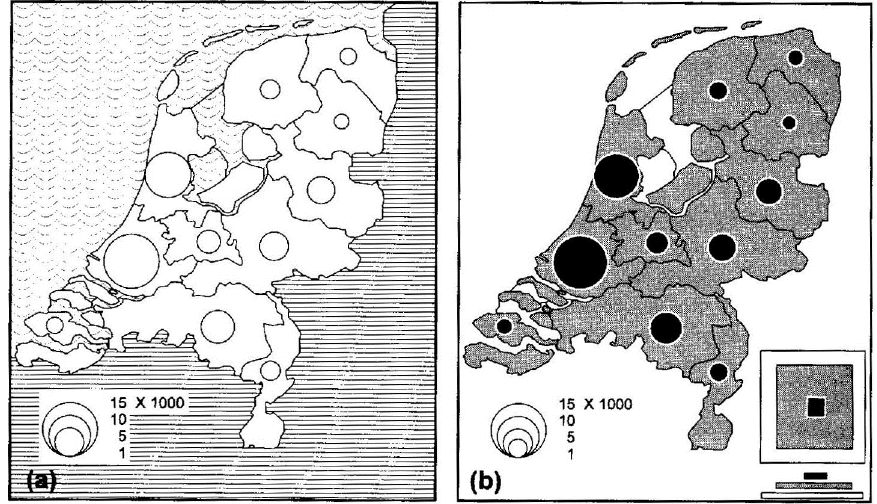
Fig. 5. The use of symbols that stand out against the background improves the map’s visual hierarchy (source: M.-J. Kraak, F. Ormeling